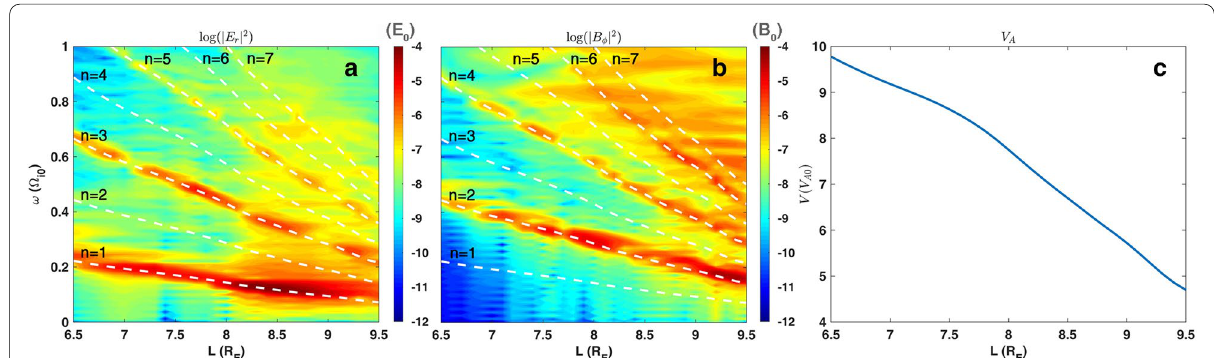
Fig. 9 Case I: radial profiles of wave power spectra of E r ( a ) and B φ ( b ) as a function of L in the noon-meridian plane. The white dashed lines mark the first 7 harmonic modes of the FLRs. The local Alfvén speed is given in c